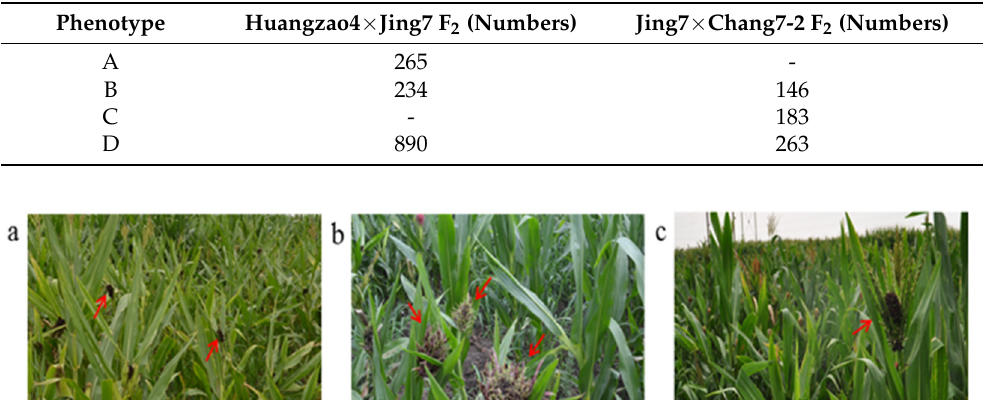
Table 1. Numbers of different tassel symptoms of maize infected with Sporisorium reilianum in two F 2 populations.